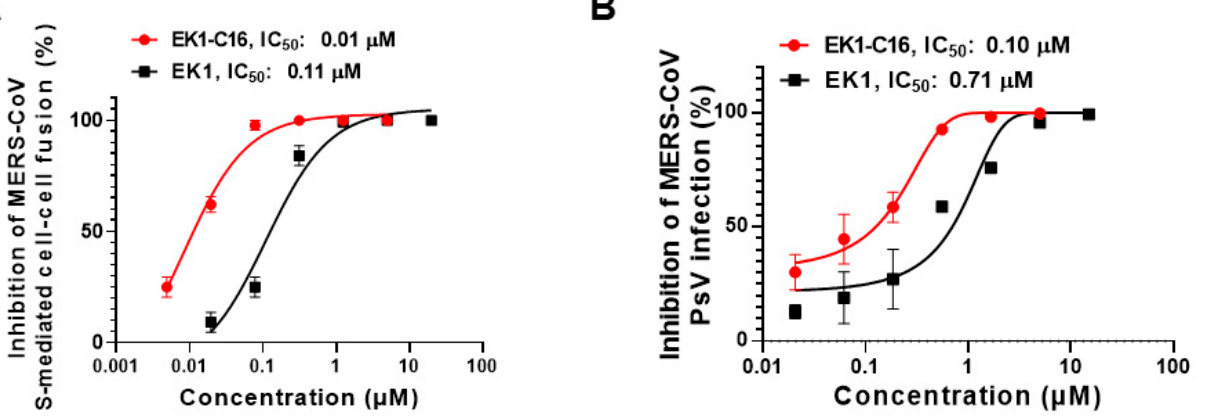
Figure 5. EK1-C16 can broadly inhibit MERS-CoV infection. ( A ) Inhibitory activity of EK1-C16 against